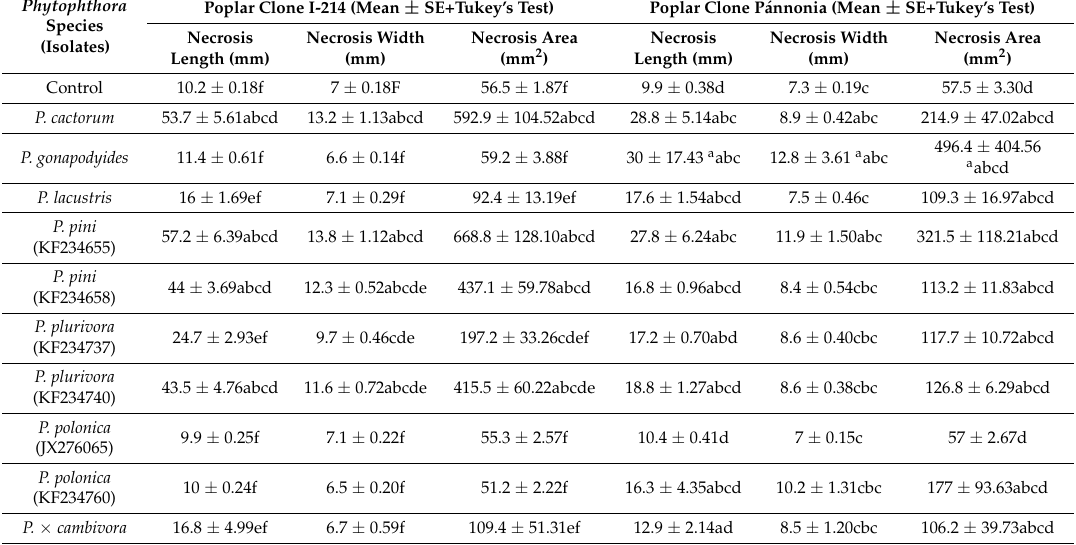
Table 5. Mean values, standard errors, and results of Tukey’s post hoc tests for the bark necroses caused by seven Phytophthora spp. in the underbark inoculation test on poplar clones I-214 and P á nnonia after 11 weeks. Different letters behind values indicate significant differences ( α =